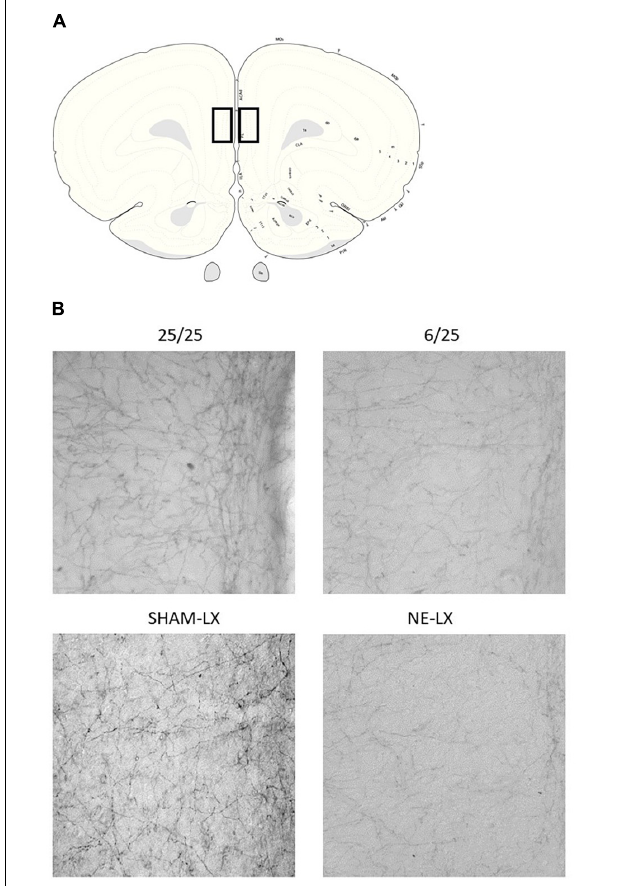
FIGURE 1 | (A) A schematic diagram of a coronal slice from the rat brain approximately 3.7 mm anterior to Bregma. Black squares indicate the location of the prelimbic cortex (PL) (Paxinos and Watson, 2007). (B) Photomicrographs of the PL showing noradrenergic axons stained for dopamine beta hydroxylase (DBH). The top left image is taken from well-nourished control rats (25/25) and is compared to subjects exposed